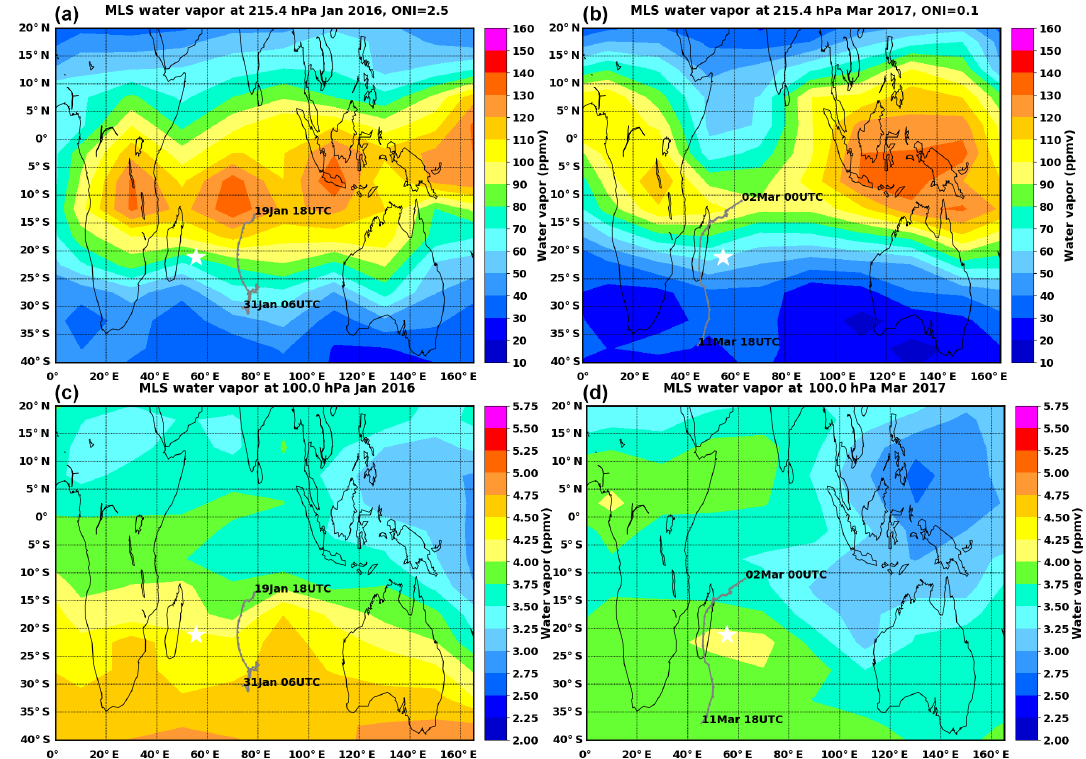
Figure 3. MLS water vapor mixing ratios (ppmv) gridded in the SWOOSH dataset at 215hPa for January 2016 (a) and for March 2017 (b) . The gray lines correspond to the best tracks of TS Corentin (19–31 January 2016) and TC Enawo (2–11 March 2017). (c, d) Same as (a) and (b) but for